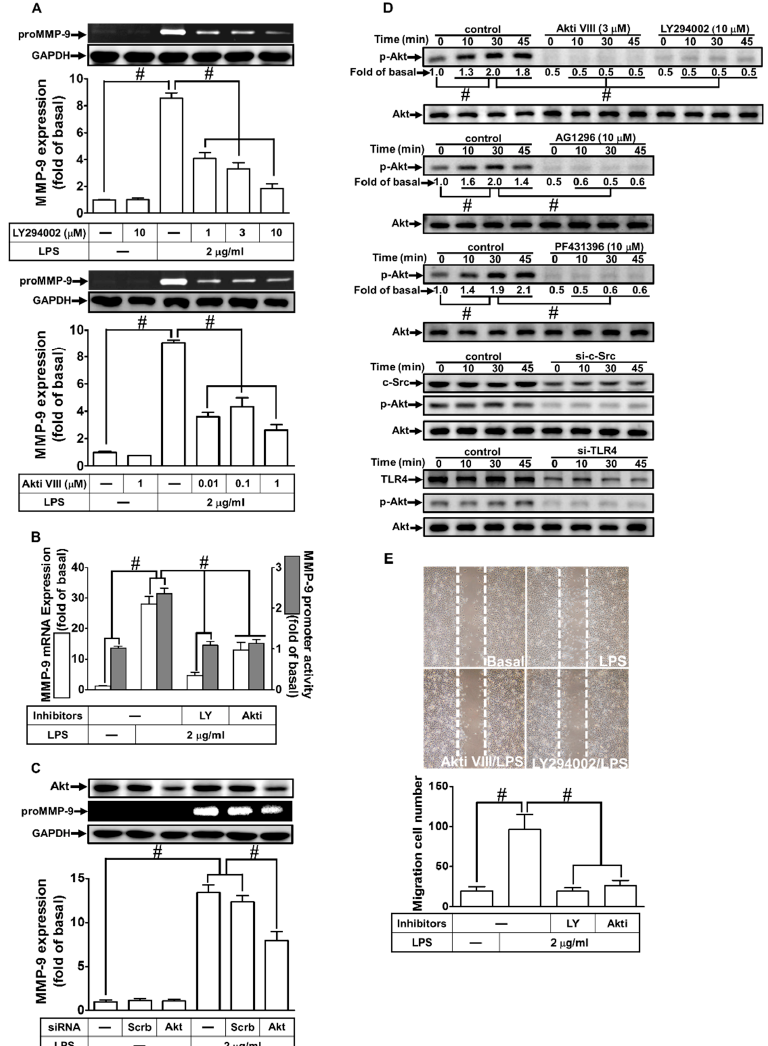
Figure 6. Phosphoinositide 3-kinase (PI3K)/protein kinase B (Akt) pathway was involved in LPS-induced MMP-9 expression and cell migration. ( A ) RBA-1 cells were pretreated with LY294002 (1, 3, and 10 μ M) or Akt inhibitor VIII (0.01, 0.1, and 1 μ M) for 1 h, independently, and then incubated with LPS (2 μ g/mL) for 24 h. The levels of MMP-9 were determined by gelatin zymography. The GAPDH level of cell lysates was assayed by western blot. ( B ) Cells were pretreated with LY294002 (10 μ M) or Akt inhibitor VIII (1 μ M) for 1 h, independently, and then incubated with LPS (2 μ g/mL) for 4 h for mRNA expression or 6 h for promoter activity. The mRNA expression and promoter activity of MMP-9 were determined by real-time PCR and promoter assay, respectively. ( C ) Cells were transfected with scrambled (Scrb) or Akt siRNA, and then incubated with LPS (2 µ g / mL) for 24 h. The medium and cell lysates were collected to respectively determine the levels of MMP-9 by gelatin zymography, and the levels of GAPDH and Akt by western blotting. ( D ) Cells were pretreated with or without LY294002 (10 µ M), AKT inhibitor VIII (3 µ M), AG1296 (10 µ M), or PF431396 (10 µ M) for 1 h, or separately transfected with either TLR4 or c-Src siRNA, and then challenged with LPS (2 µ g / mL) for the indicated time intervals (0, 10, 30, and 45 min). The phosphorylation of Akt was determined by western blotting. ( E ) Cells were pretreated with Akt inhibitor VIII (1 µ M) or LY294002 (3 µ M) for 1 h, and then incubated with LPS (2 µ g / mL) for 48 h. The number of cell migrations was determined (magnification = 40 × ). Data are expressed as mean ± SEM of three independent experiments. # p < 0.01 as compared with the cells exposed to vehicle or LPS, as